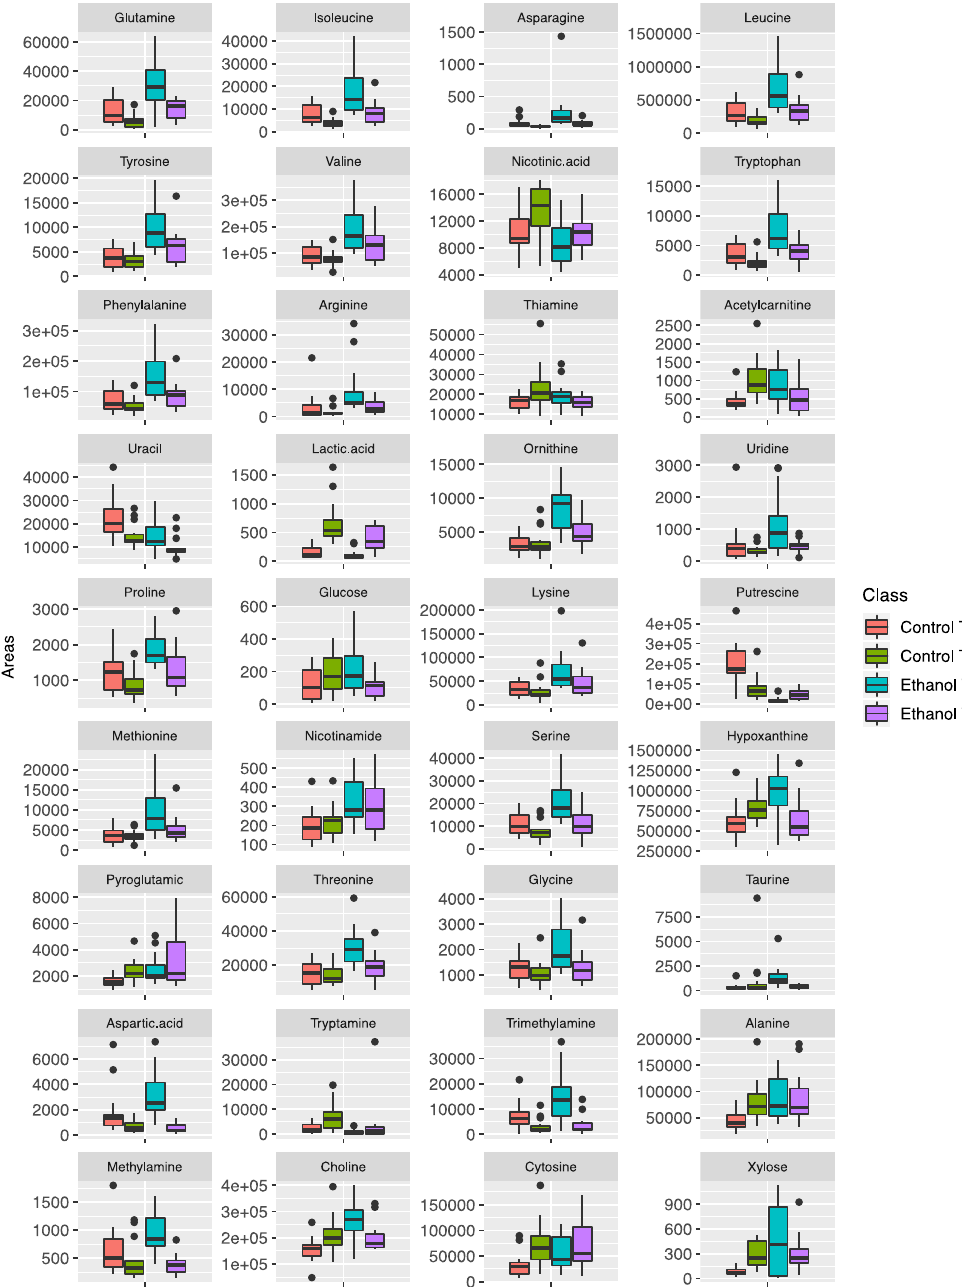
Figure 3. Box plots for the metabolites that were found to differentiate significantly in the fecal samples from ethanol treated mice.